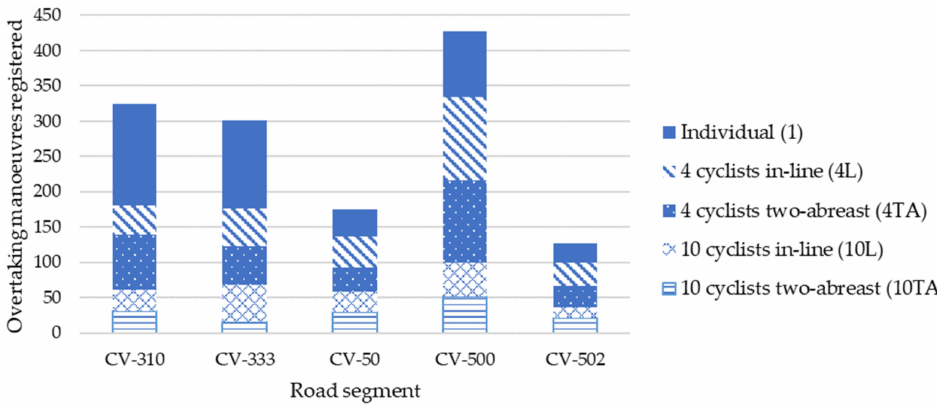
Figure 3. Overtaking manoeuvres registered per road segment and cyclist group